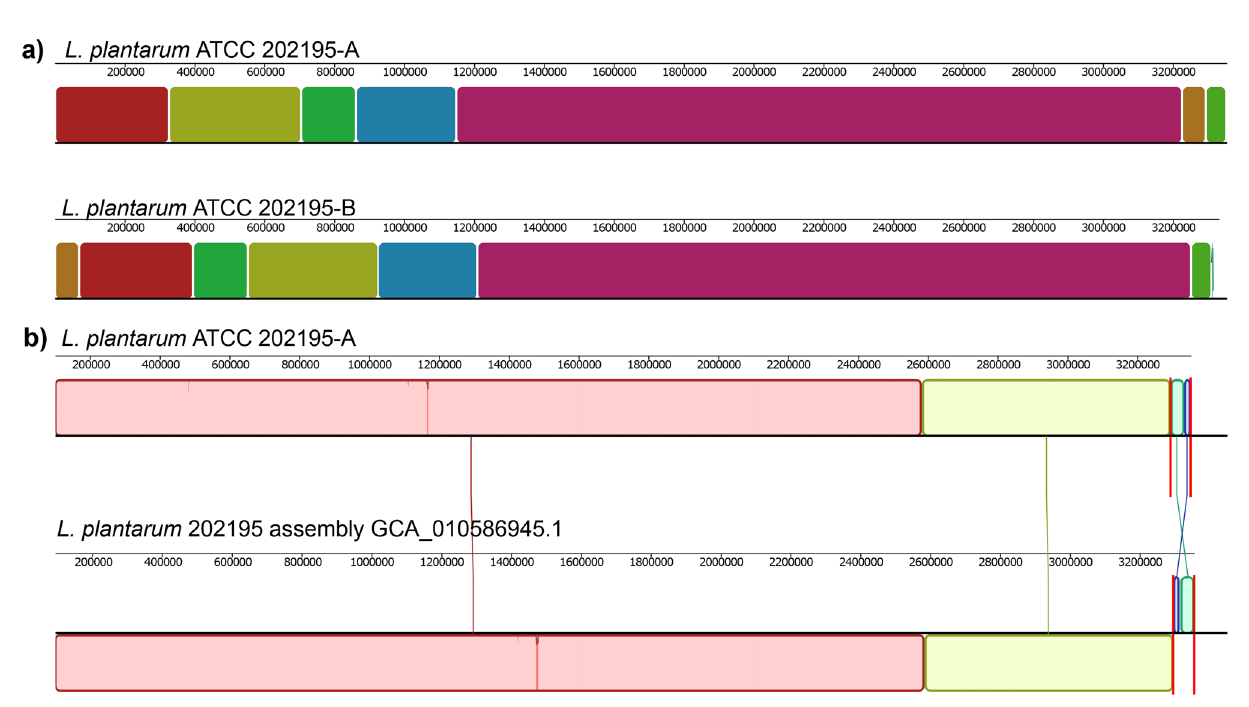
Figure 2. Comparison of sequenced isolates of L. plantarum ATCC 202195 ( a ) Graphical representation of a global sequence alignment of the co-linear blocks (identified using progressiveMAUVE 27 ) conserved between the L. plantarum ATCC 2021295-A and L. plantarum ATCC 2021295-B genomes. ( b ) Mauve alignment of L. plantarum ATCC 202195-A and Lactiplantibacillus plantarum ATCC 202195 assembly GCA_010586945.1. Matching coloured blocks correspond to co-linear blocks shared between the sequences. The original image was generated by Mauve software (http:// darli nglab. org/ mauve/ user- guide/ mauve align er. html) and edited in Inkscape v1.0.1 (https:// inksc ape. org/ relea se/ inksc ape-1.